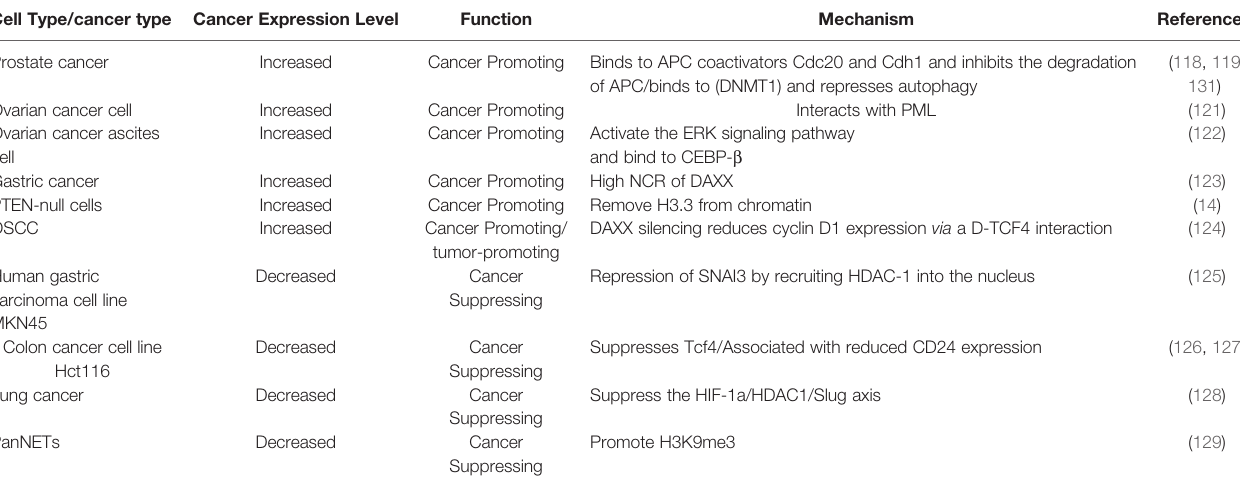
TABLE 4 | Expression and mechanism of DAXX in